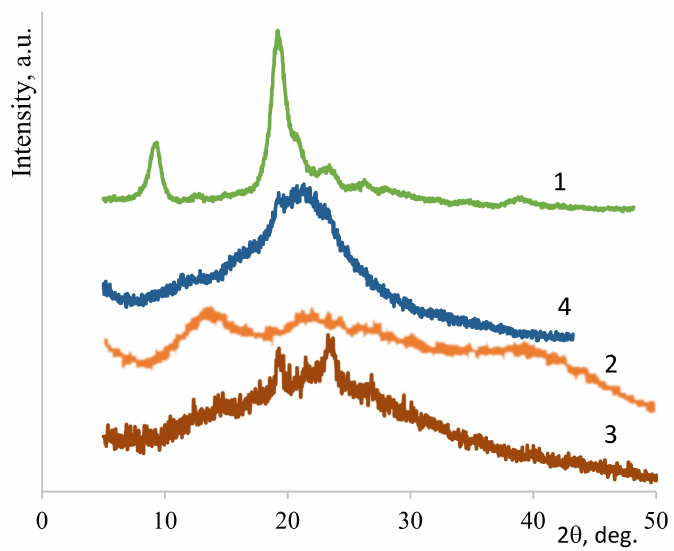
Figure 4. X-ray di ff raction patterns: PEO-nonwoven (1), CS-film (2), CS–PEO-nonwoven (3).